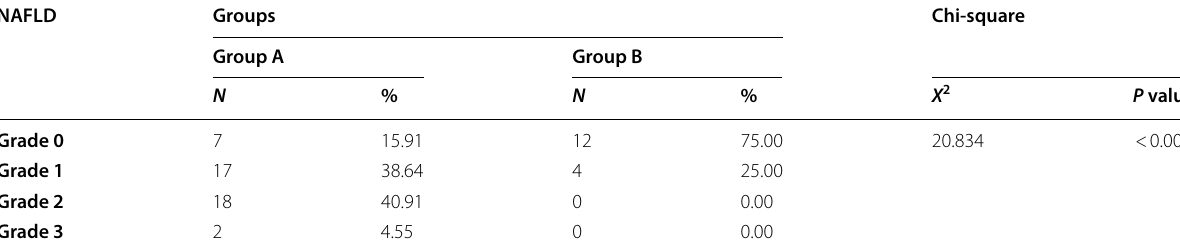
NAFLD non-alcoholic fatty liver disease, N number, % percentage *